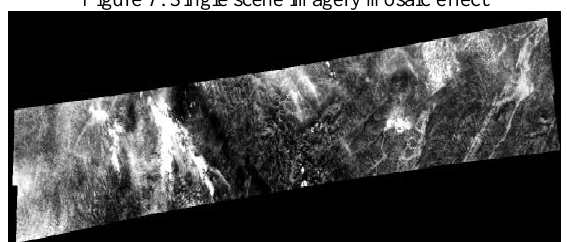
Figure 7. Single scene imagery mosaic effect